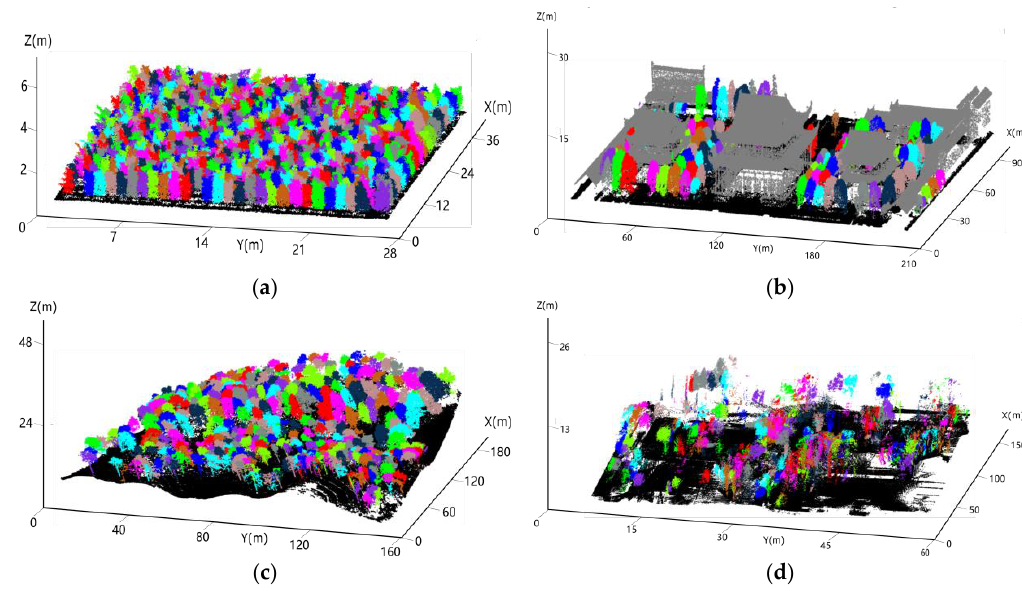
Figure 8. Program diagrams showing our results of individual tree crown segmentation, where different colours indicate the segmentation results for each tree. ( a – d ) show the partial segmented LiDAR data for the nursery base, monastery garden, mixed forest and defoliated forest, respectively.